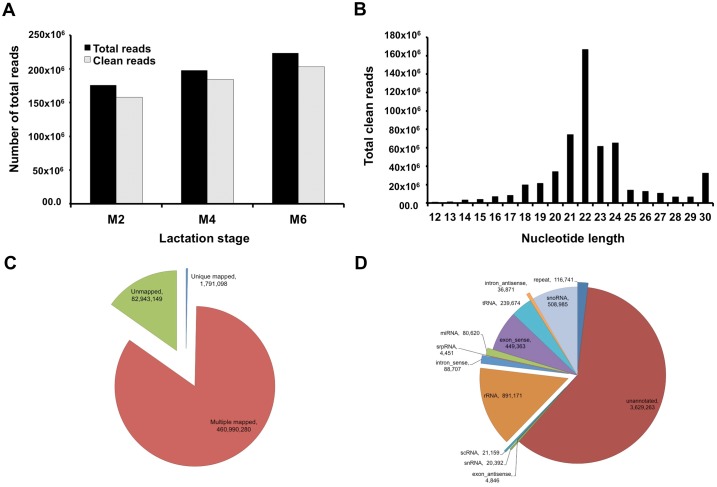
Annotation and filtering analysis of all clean small reads.(A) After the filtering analysis of the total reads, the total number of raw generated clean reads compared to the filtered clean reads is presented. (B) Total clean reads of small RNAs distributed based on their nucleotide length (12–30 nt). (C) Total raw and clean reads for each lactation stage (months 2, 4 and 6). (D) Small RNA unique reads categorised into only one RNA type, including miRNAs, using the following priority rule: rRNAetc (in which Genbank > Rfam) > known miRNA > piRNA > repeat > exon > intron3.